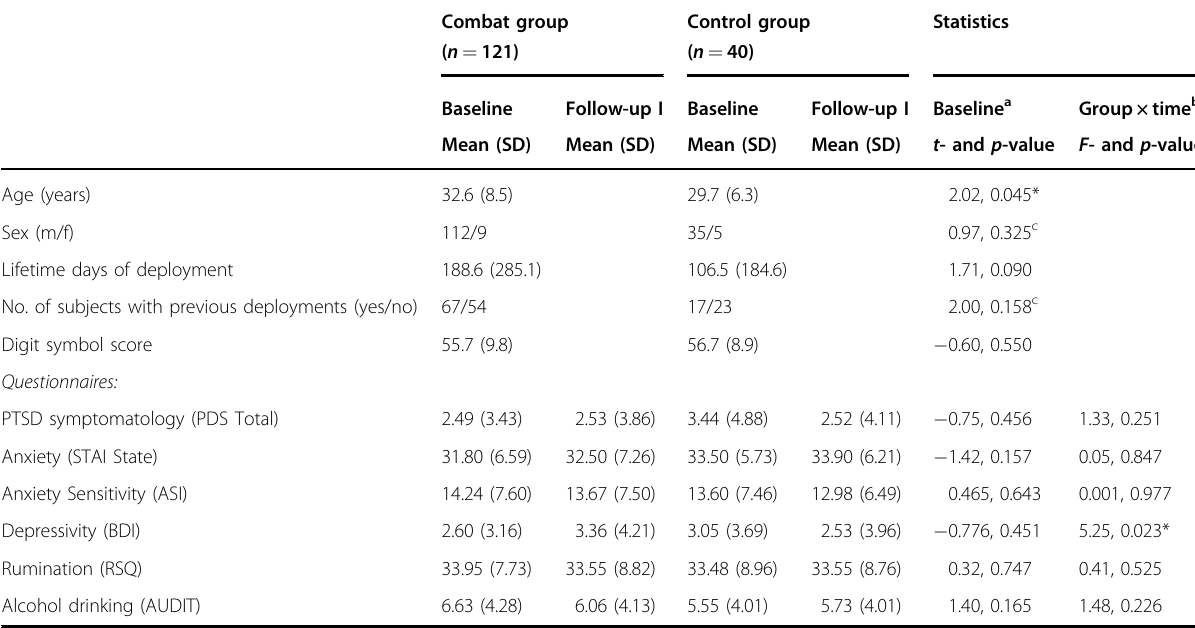
Table 1 Descriptive information on study